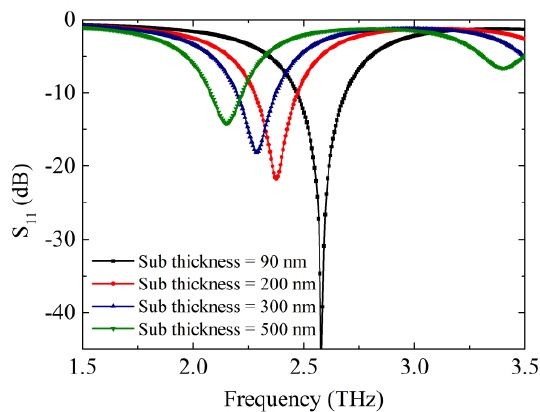
Figure 9. Simulated reflection coefficient with different substrate thickness values, 90 nm, 200 nm, 300 nm, and 500 nm. The arm length is 5 µm, the temperature is 300 K, and the relaxation time is 0.5 ps.